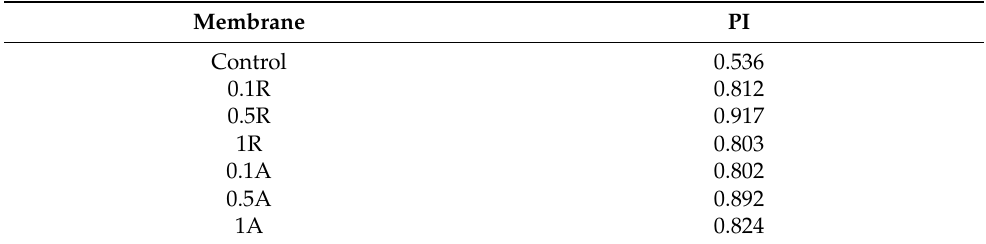
Figure 11. Performance of control membrane and membranes with nanoparticle additions of TiO 2 rutile and anatase. Table 7. Analysis of total membrane performance results regarding the incorporation of titanium dioxide